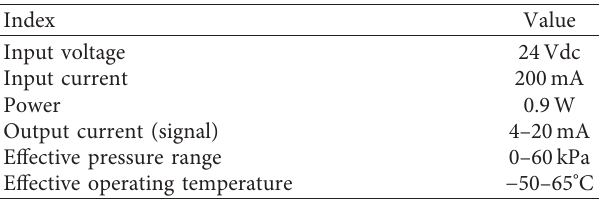
Table 1: Technical parameters of the Rosemount 3051S hydrostatic levelling system.